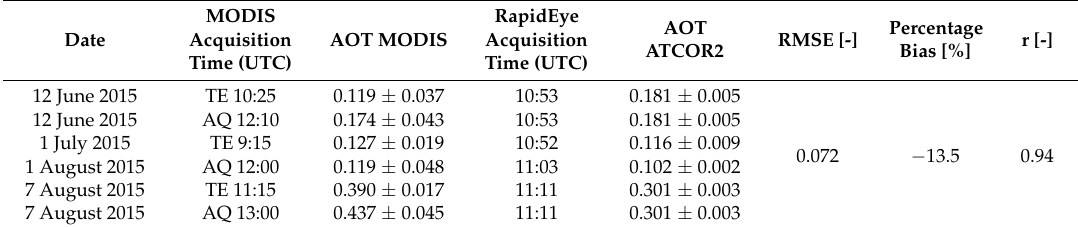
Table 5. Mean and standard deviation of AOT at 550 nm values retrieved from RapidEye data during ATCOR2 atmospheric correction in comparison to MODIS product AOT at 550 nm values [50,51] in a 3 × 3 (30 × 30 km 2 ) pixel environment covering the study